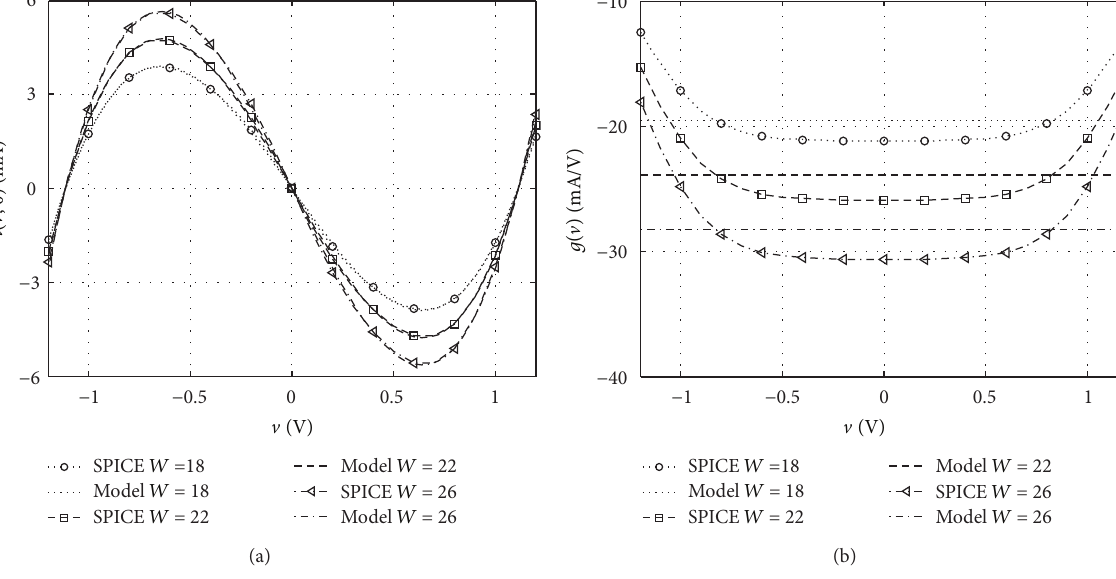
Figure 7: Current-voltage characteristics of the circuits in Figure 6. (a) Total current 𝑖( V ,0) = 𝑖 controlled transconductance 𝑔 1 ( V ) . SPICE simulations are obtained by using BSIM3 transistor models (MOSIS-IBM 8RF 0.13 𝜇 technology), = 1.2 V. Analytical models are obtained by using polynomial approximations 𝑖( V ,0) = 𝑎 with 𝑉 DD